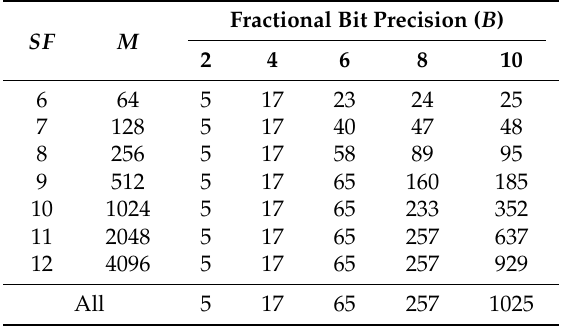
Table 4. N in for LoRa systems with various levels of quantization.